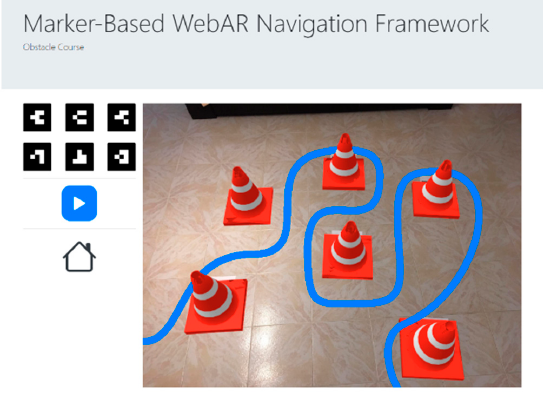
Figure 9. Simple obstacle course, where the objective is to contour the cones (the blue line was added later as an example of a trajectory).